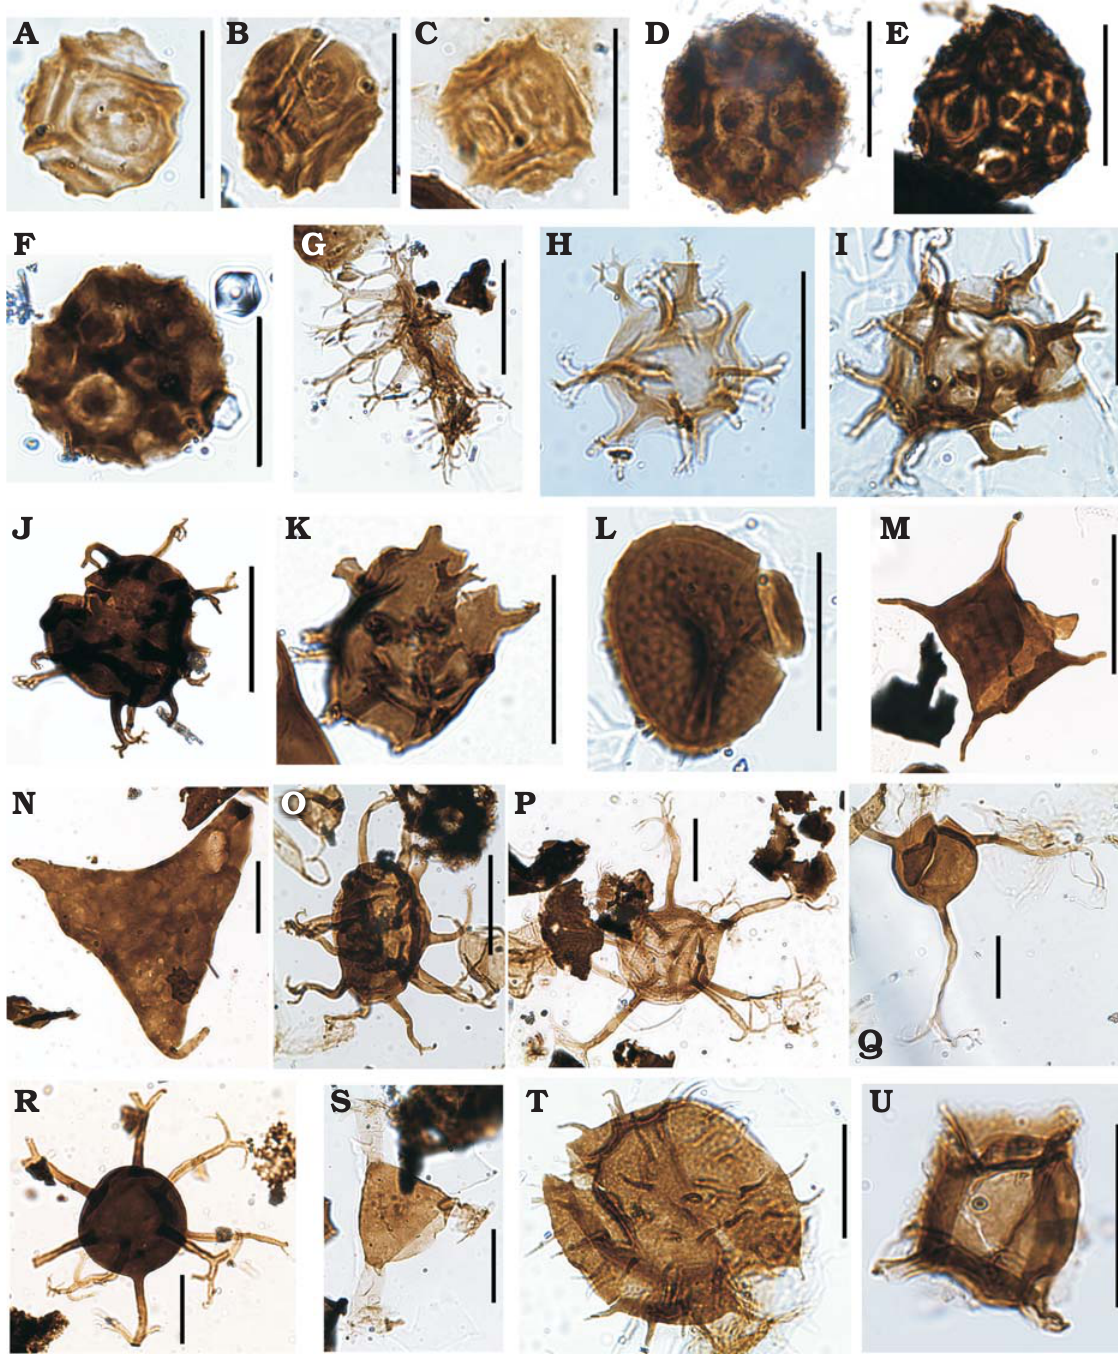
Fig. 9. Palynomorphs from the studied sections of the Los Espejos Formation of Argentina, Cerro La Chilca, Homerian? (A, L), Cerro La Chilca, Gorstian?–Ludfordian? (B, I), Cerro La Chilca, Ludfordian (C, H, O, Q, T), Quebrada Ancha, Ludfordian (D–G, J, N, P, R, S), Quebrada Ancha, P ř ídolí (K, U), Quebrada Ancha, Gorstian?–Ludfordian? (M). A – F . cf. Melikeriopalla sp. A . MPLP 1-61065 (W30/3). B . MPLP 3-61058 (L33). C . MPLP 7-61062 (P43/3). D . MPLP 2-60704 (L26). E . MPLP 3-60659 (F38). F . MPLP 4-62521 (T40/4). G . Multiplicisphaeridium arbusculum forma A of Mullins (2001); MPLP 7-60736 (D30/1). H . Multiplicisphaeridium cladum (Downie, 1963) Eisenack, 1969; MPLP 4-61059 (E50/1). I . Multiplicisphaeridium mingusi Le Hérissé, 1989; MPLP 2-61057 (M31/1). J . Multiplicisphaeridium monki Le Hérissé, 1989; MPLP 3-60659 (O45/2). K . Multiplicisphaeridium rochesterensis Cramer and Diez, 1972; MPLP 9-60664 (U27). L . Nanocyclopia sp.; MPLP 1-61065 (U38/1). M . Neoveryhachium carminae (Cramer, 1964a) Cramer, 1970; MPLP 1-60667 (P45/2). N . Onondagella asymmetrica (Deunff, 1961) Playford, 1977; MPLP 7-60736 (X44). O . cf. Oppilatala frondis (Cramer and Díez, 1972) Dorning, 1981; MPLP 4-61059 (F45). P . Oppilatala grahni Le Hérissé, 1989; MPLP 7-60736 (E38/1). Q . Oppilatala insolita (Cramer and Díez, 1972) Dorning, 1981; MPLP 4-61059 (Q50). R . Oppilatala ramusculosa (Deflandre, 1945) Dorning, 1981; MPLP 7-60736 (N37/4). S . Ozotobrachion palidodigitatus (Cramer, 1966b) Playford, 1977; MPLP 7-60736 (P48/4). T . Percultisphaera incompta Richards and Mullins, 2003; MPLP 4-61059 (W47/4). U . Polyedrixium ? cf. embudum Cramer, 1964a; MPLP 9-60664 (D39/1). Scale bars 20 μ